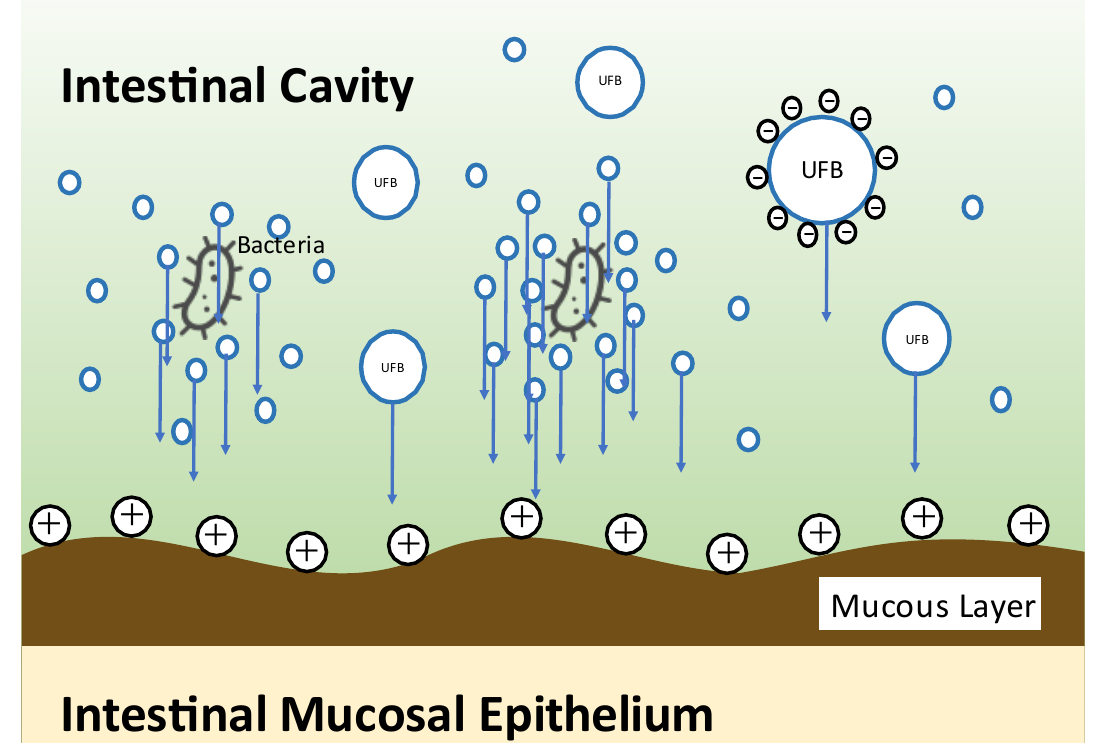
Figure 3. Illustration of bacterial engraftment by NanoGAS ® water.